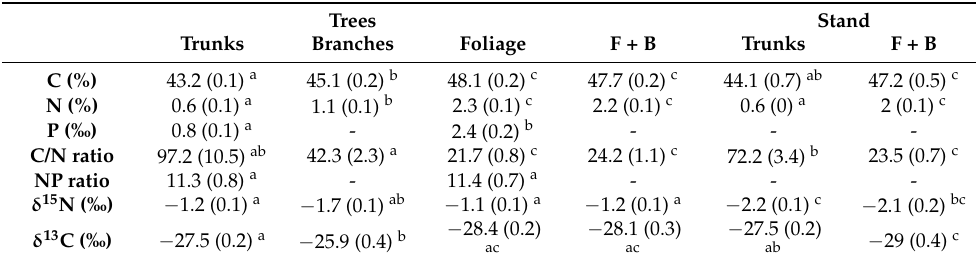
Table 2. Nutrient content, stoichiometric ratios and isotopic signatures of tissues collected for the biomass model. N = nitrogen, P = phosphorus, and C = carbon. The letters depict significant differences between the groups (pairwise Wilcoxon rank sum tests, p < 0.05); n = 11 for stands, n = 37 for singular trees. F + B = foliage and branches. Trees Stand Trunks